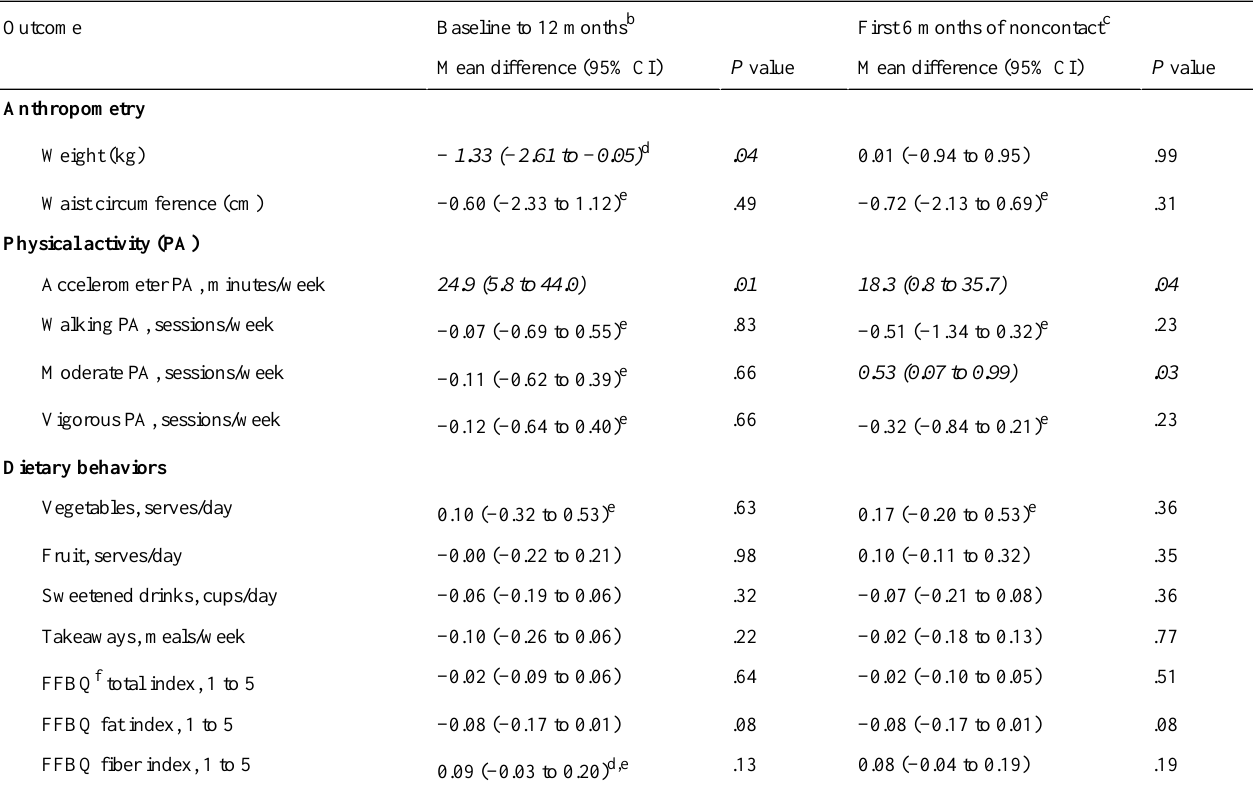
Table 2. Difference in study outcomes between the Get Healthy, Stay Healthy (GHSH) extended contact group (n=114) and control group (n=114) adjusted for baseline values of the outcome and potential confounders a .